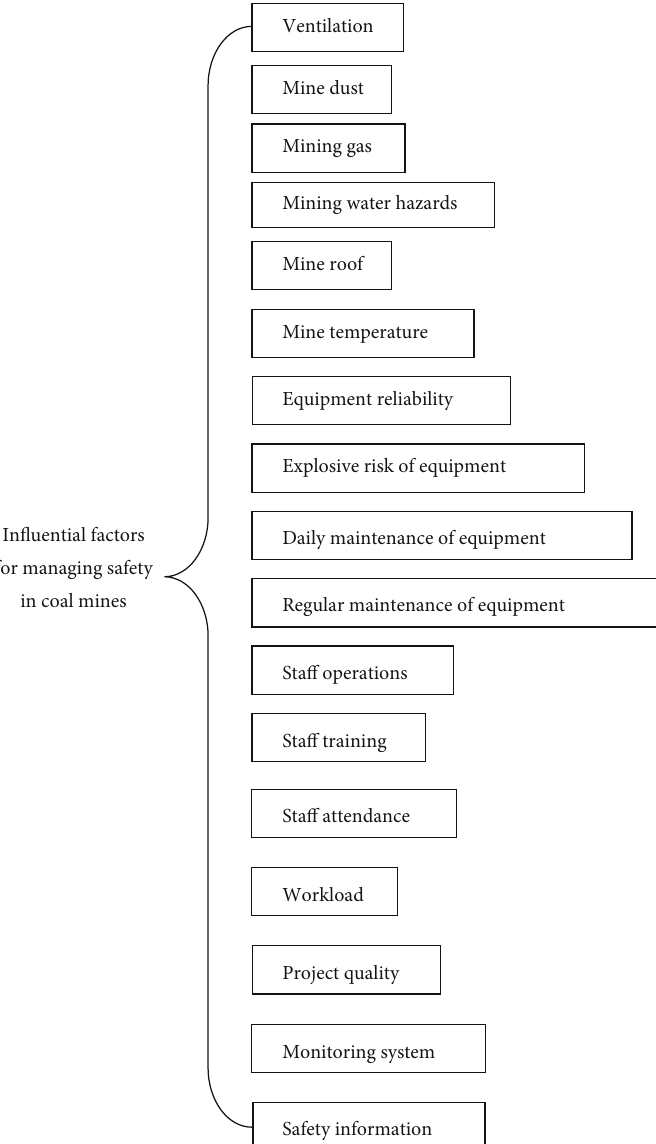
Figure 1: In fl uential factors for managing safety in coal